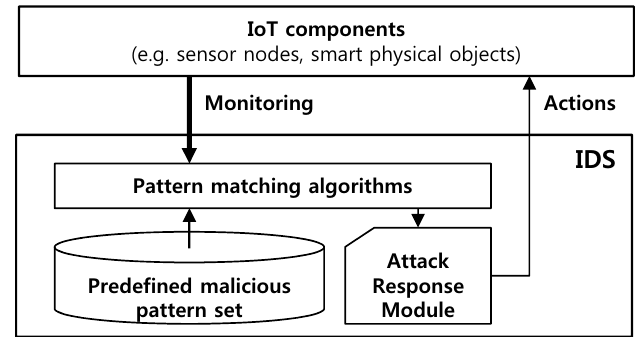
Figure 1. Architecture of intrusion detection